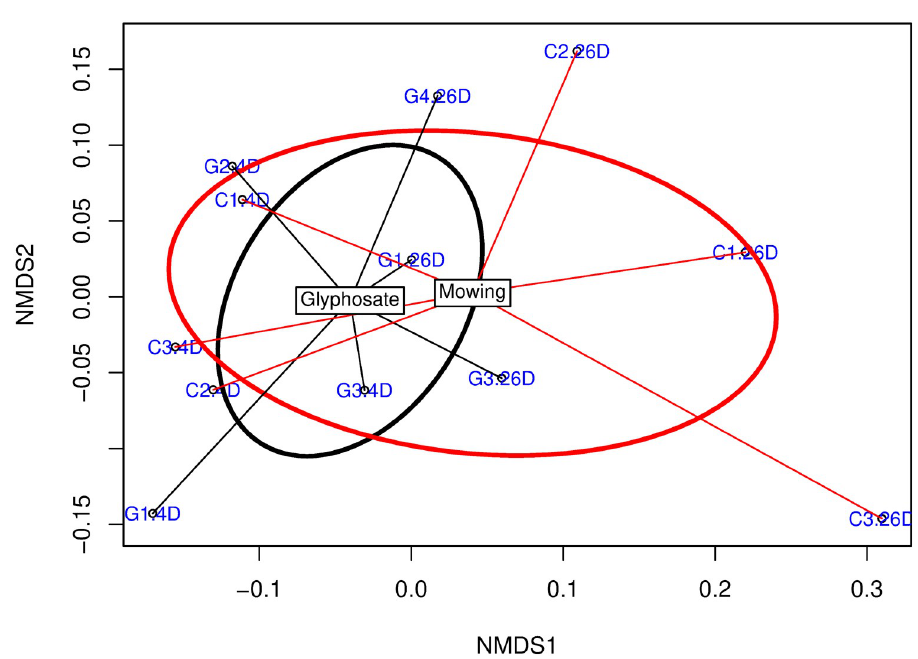
Fig 2. Multivariate analysis of the metabarcoding dataset in the rhizosphere of Avena sativa . Letter C indicates mowing suppression and letter G desiccation with glyphosate. The number after the letter refers to the replicate while the number after the point indicates the sampling time (.4D: 4 days; .26D: 26 days). Centroids are indicated in black boxes. Standard deviation is shown by red (C) or black (G) ellipses. Ordination was conducted using non-metric multidimensional scaling (NMDS) and Generalized UniFrac distance metric. Stress-value = 0.082.